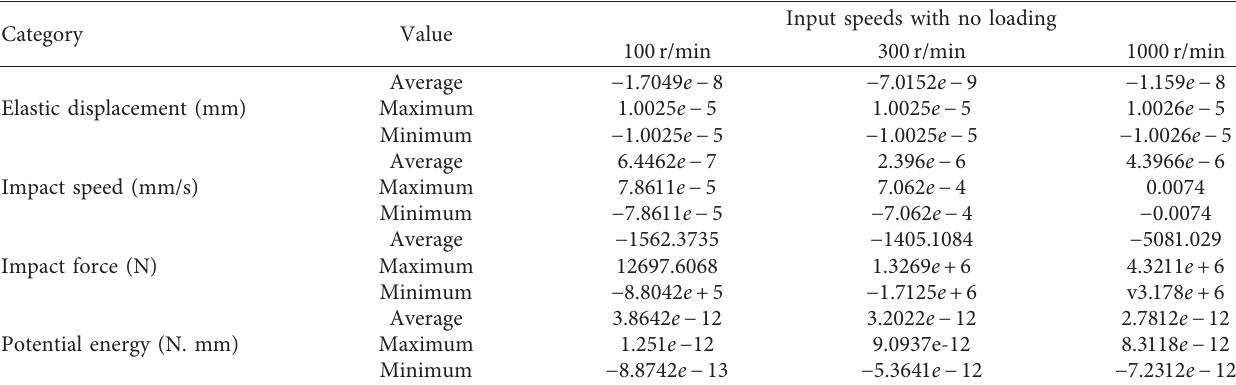
Table 2: Impact characteristics of second-stage face gear pair without load.